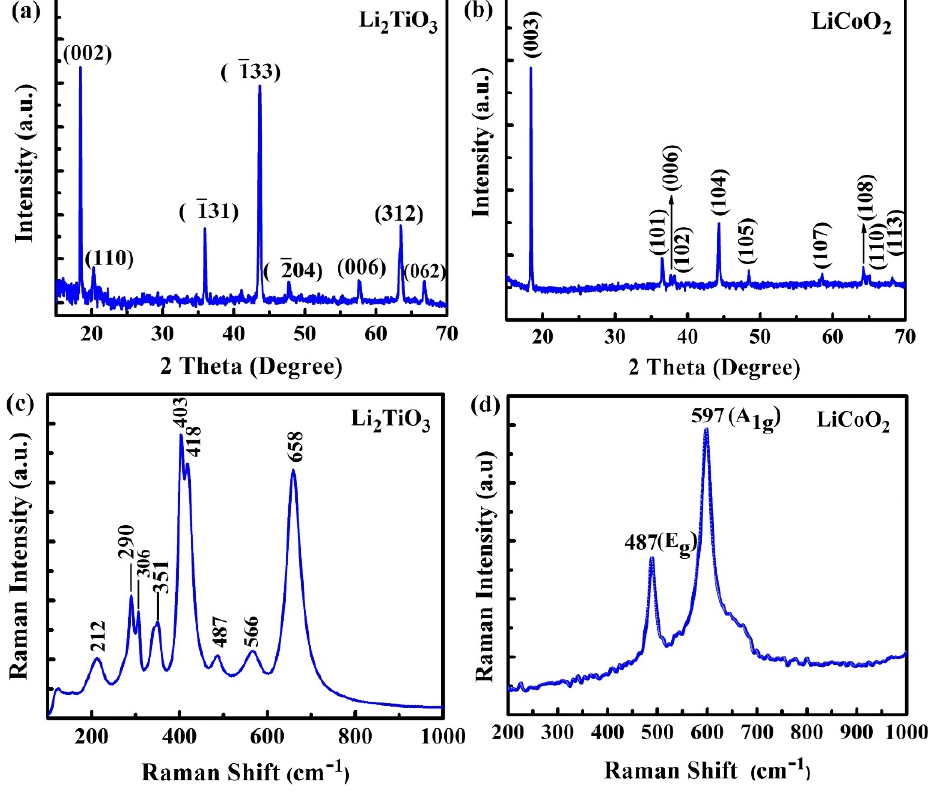
Figure 1. X-ray diffraction patterns of Li 2 TiO 3 ( a ) and LiCoO 2 nanoparticles ( b ) recorded with the X-ray source CuK α ( λ = 1.5406 Å) filtered by Ni film at a scan speed of 0.03 degree per second. Raman spectra of Li 2 TiO 3 ( c ), and LiCoO 2 ( d ) nanoparticles recorded with a 532 nm laser excitation line. The Li-Ti-O framework is formed during the hydrothermal synthesis reaction; it is characterized by the basal lattice plane (133), suggesting the correct ordering of lithium and titanium ions in the LiTi 2 slab of the monoclinic structure. In the Li 2 TiO 3 crystal, Li, Ti, and O atoms are arranged in the sequence Li interslab (Li 1/3 Ti 2/3 ) slab O 2 , in which Ti ions occupy 2/3 of other 4 e sites (Wyckoff notation) and Li ions occupy 1/3 of 4 e sites [30].